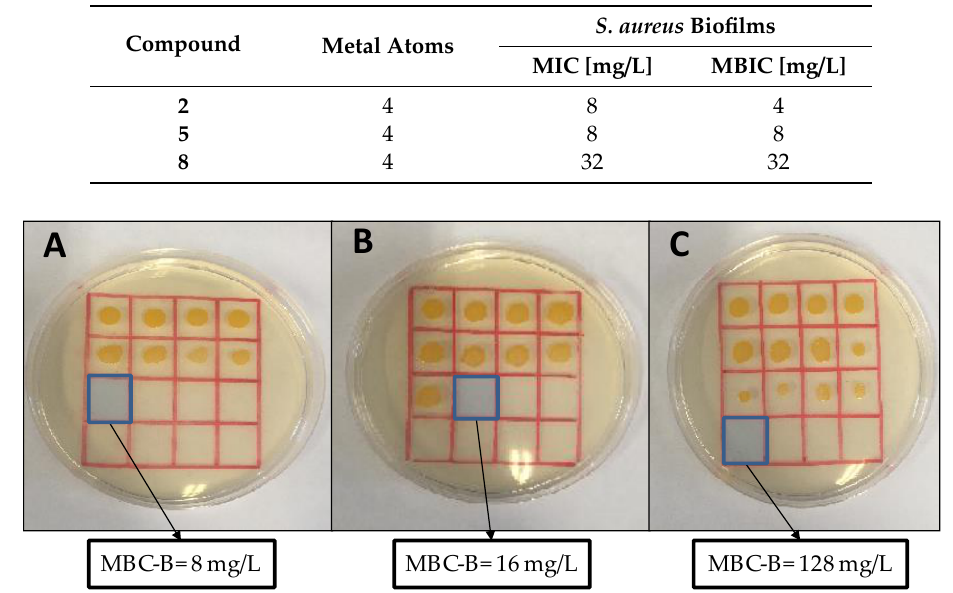
Figure 2. Effect of first-generation metallodendrimers in preventing the formation of S. aureus biofilms. ( A ) Compound 2 , with Cu(II) nitrate complex; ( B ) compound 5 , with Cu(II) chloride complex; and ( C ) compound 8 , with Ru(II) Cp/PTA complex. The Minimum Bactericidal Concentration for Biofilms (MBC-B) represents the minimal concentration of the metallodendrimer that can kill the microorganism in the conditions used to produce a